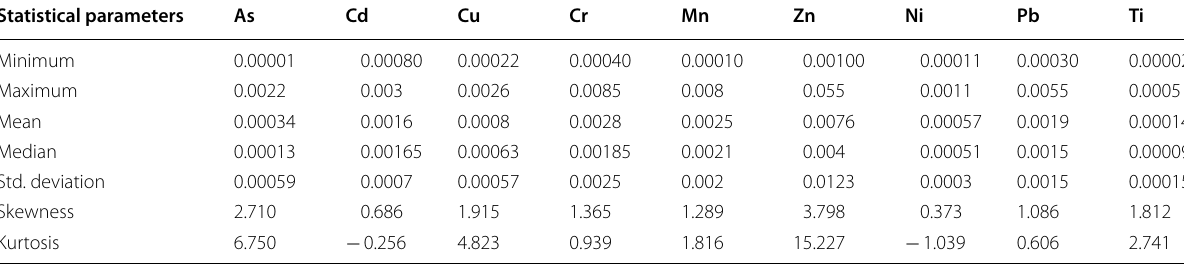
Table 10 Statistical parameters of the contamination factor Statistical parameters